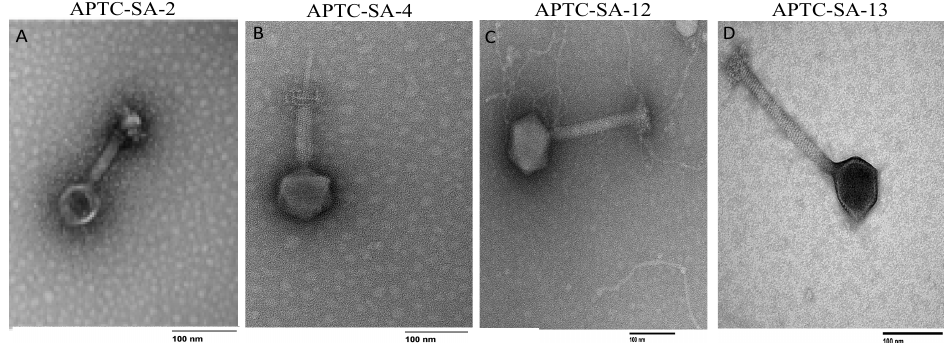
Figure 5. Morphology of Staphylococcus phages. Transmission electron microscopy images of S. aureus phage ( A ) APTC-SA-2, ( B ) APTC-SA-4, ( C )APTC-SA-12, and ( D ) APTC-SA-13. Scale bar: 100 nm.